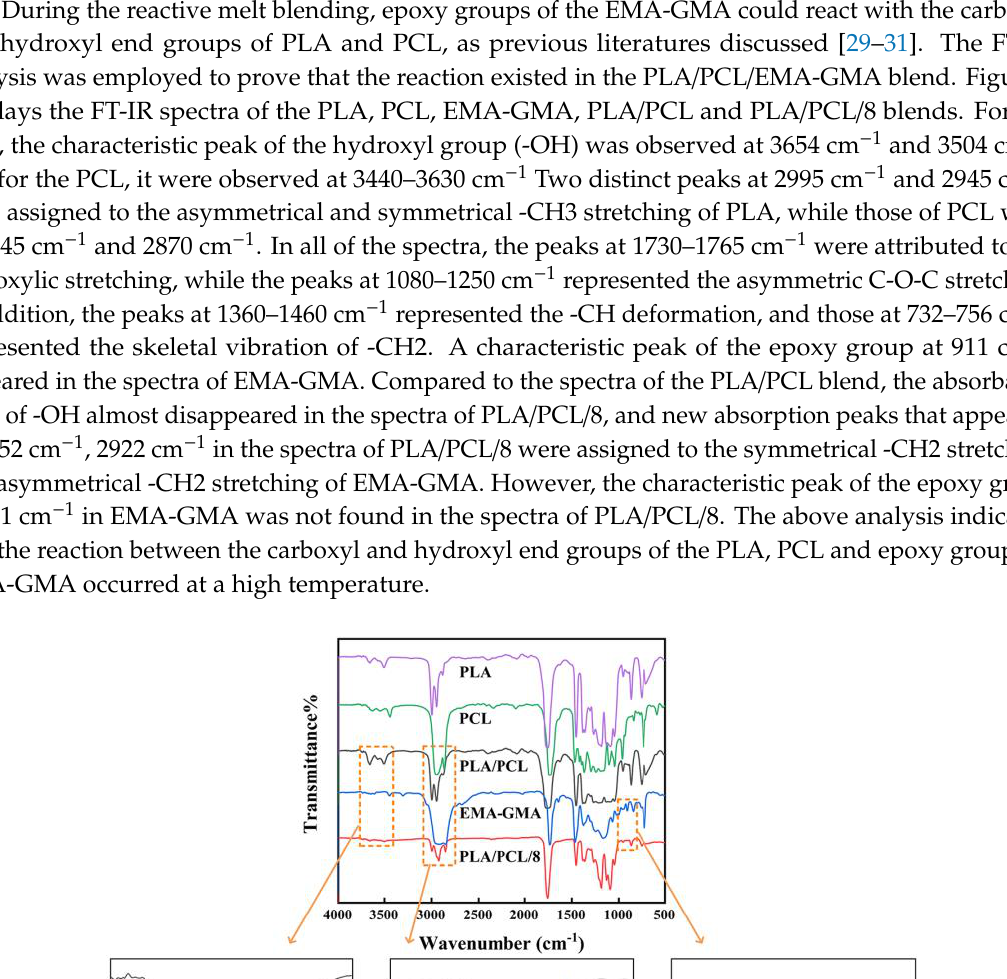
Figure 1. FT-IR spectra of the PLA, PCL, EMA-GMA, PLA/PCL and PLA/PCL/8 blends.